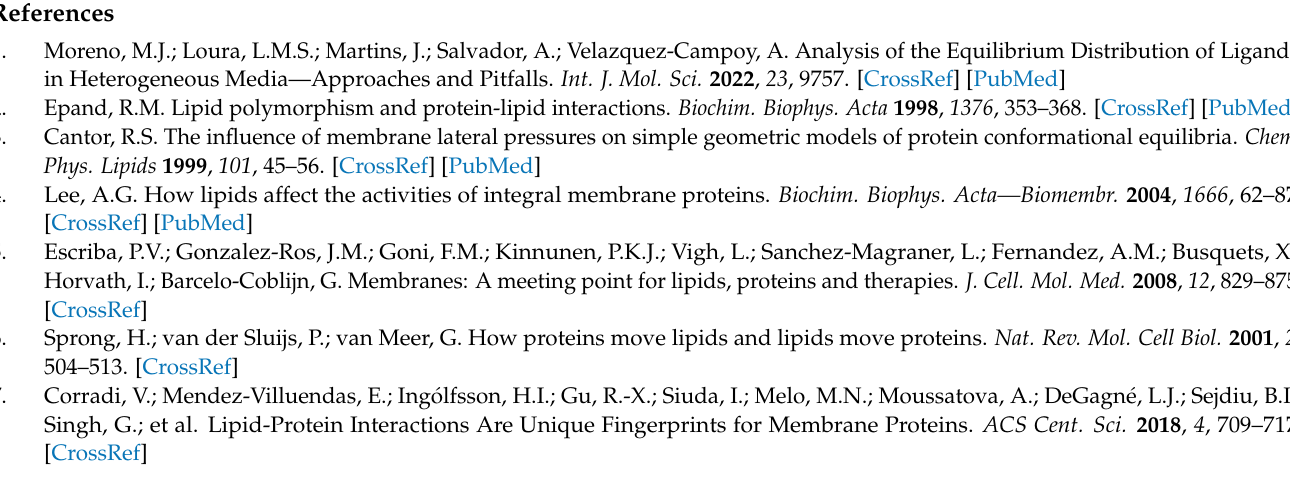
L = 1, middle plots), or that the affinity for the protein K = 1, middle plots), or that the affinity for PP P P (cid:17) 2 (cid:16) ( ) 2 L L = K L W = 1, right plots); for = 1 µ M, K K = = 1, right plots); for PP PLb W W P P P Lb